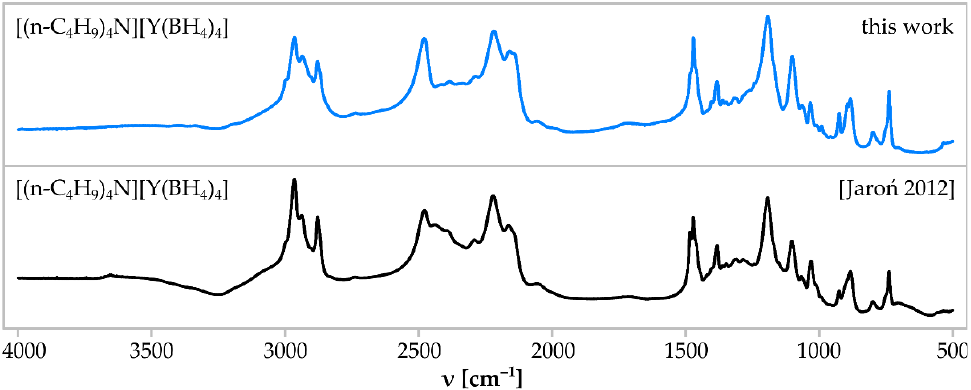
Figure 2. Comparison of IR absorption spectrum of the sample 1 comprising [(n-C 4 H 9 ) 4 N][Y(BH 4 ) 4 ] ( top , blue line) and a reference spectrum of [(n-C 4 H 9 ) 4 N][Y(BH 4 ) 4 ] obtained in a classical mechanochemical method ( bottom , black line) [32].